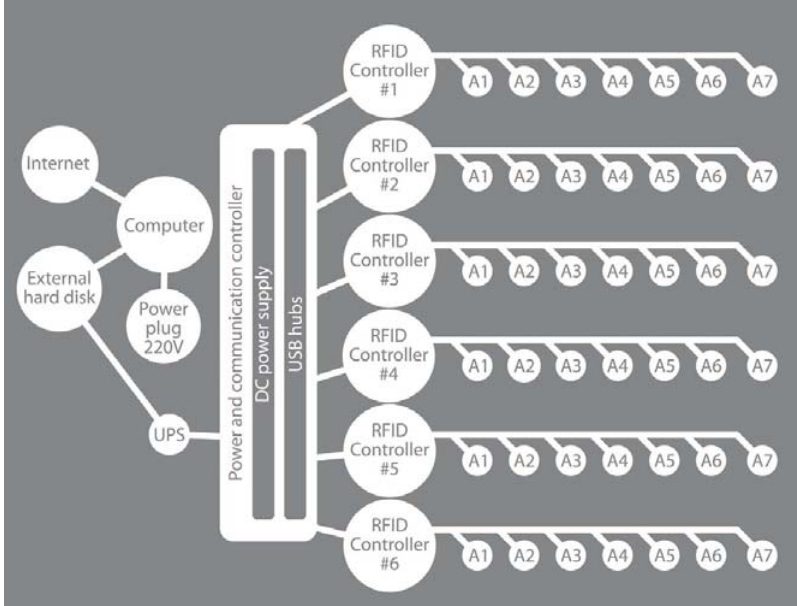
Figure 3. Organisational scheme of the relationships among the different elements composing the RFID system used to track behavioural rhythms in a group of Nephrops within a laboratory microcosm tank. The system is composed of the six controllers, each potentially connectable to seven antennas (A) and a signal storing tool ( i.e. , the laptop) connected via USB hubs. Although 42 antennas could have been installed, our tank specifications required us to modify this design and to reduce the number of antennas that were connected to controllers 2 and 3, see Figure